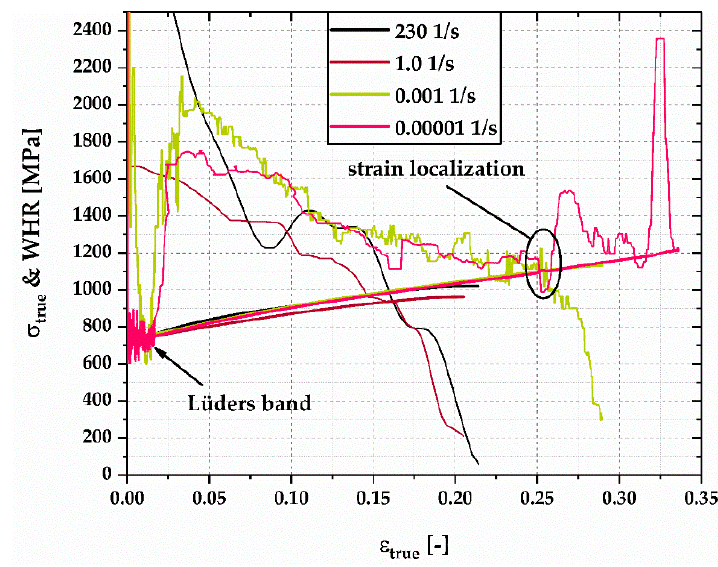
Figure 6. Flow curve and work-hardening rate (WHR) of the X6MnAl12-3 alloy tested at 0.00001 1/s, 0.001 1/s, 1.0 1/s, and 230 1/s, respectively.